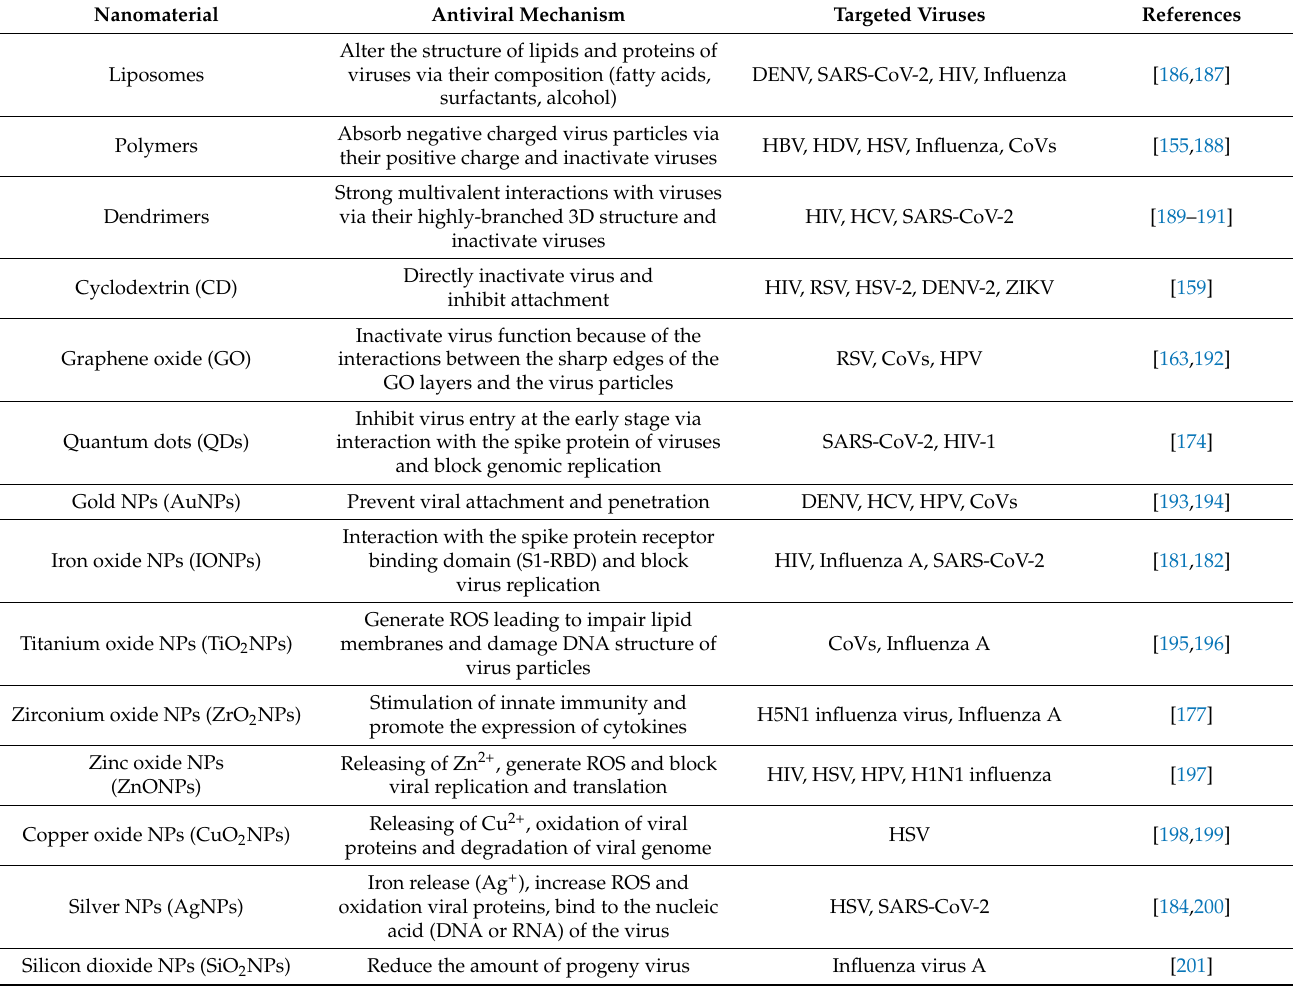
Table 1. An overview of the antiviral mechanisms of multivalent